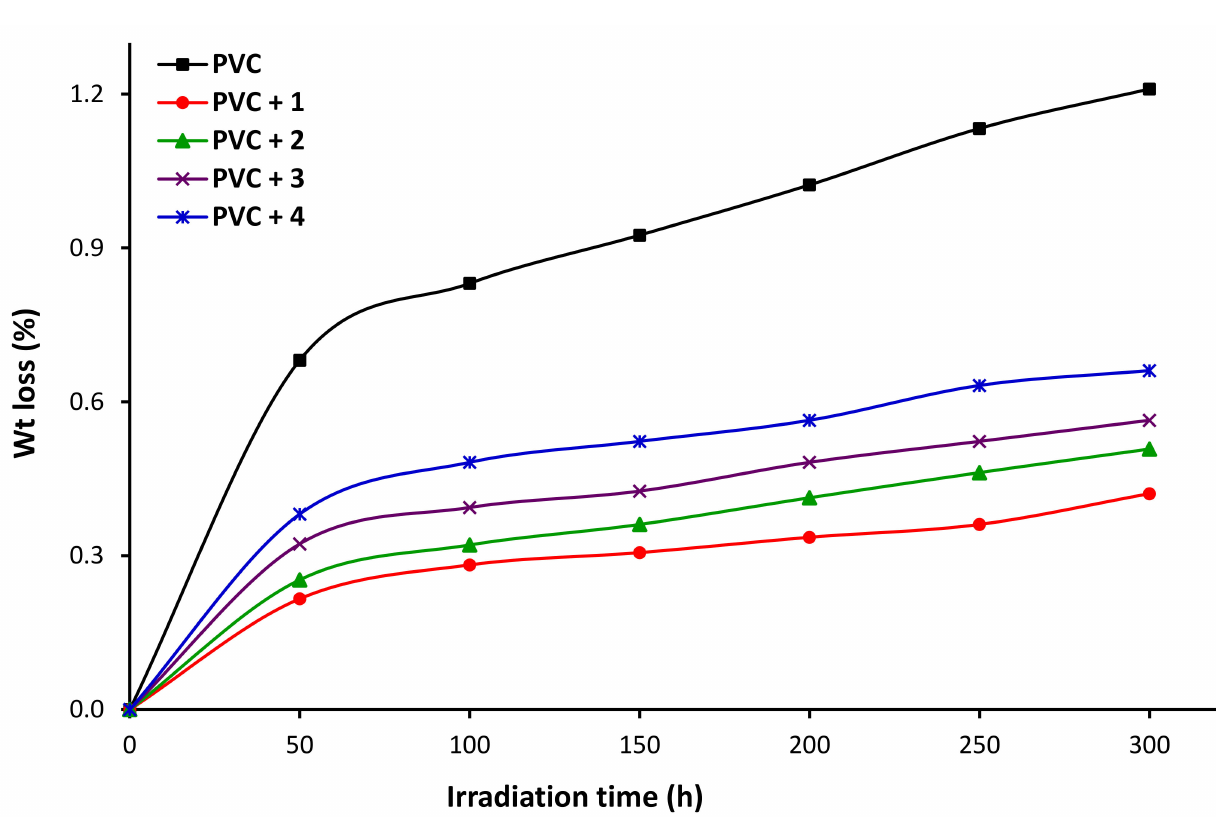
Figure 1. Percentage weight loss as a function of time during the irradiation of pure and tin-complex blended PVC. The impact of irradiation on the indices of –CH=CH– ( I C=C ), –C=O ( I C=O ), and –OH ( I OH ) are shown in Figures 3–5, respectively. The changes in I C=C , I C=O , and I OH were less significant for the films containing Sn complexes. The results reflect the role played by the Sn complexes of 4-methoxybenzoic acid in reducing the impact of irradiation on the PVC films. The changes in the indices of the functional groups were fastest during the first 70 min and continued throughout the irradiation process. Complex 1 , with its high aromaticity, led to the least photodegradation. After 300 h of PVC exposure to UV light, I C=C was 0.19 (PVC + 1 ), 0.21 (PVC + 2 ), 0.24 (PVC + 3 ), 0.27 (PVC + 4 ), and 0.46 (blank PVC). Similar results were also seen for I C=O and I OH